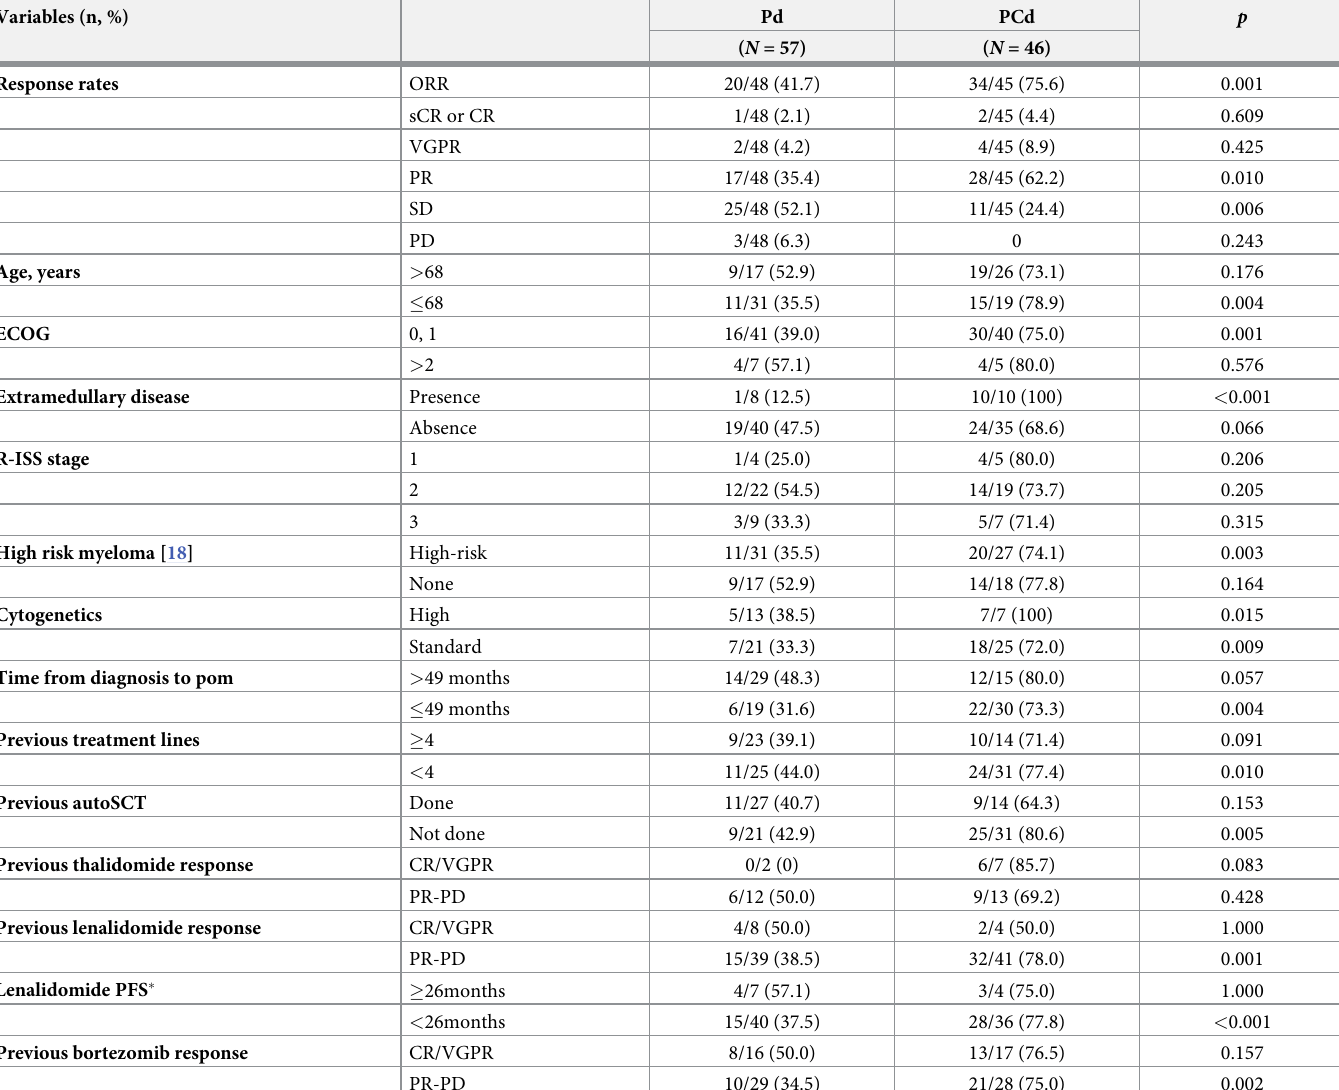
Table 2. The Overall Response Rates (ORR) and predictive factors for ORR. Variables (n,